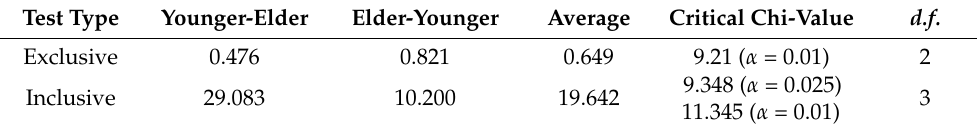
Table 10. Results of chi-test on student’s results and actions from the two age groups.